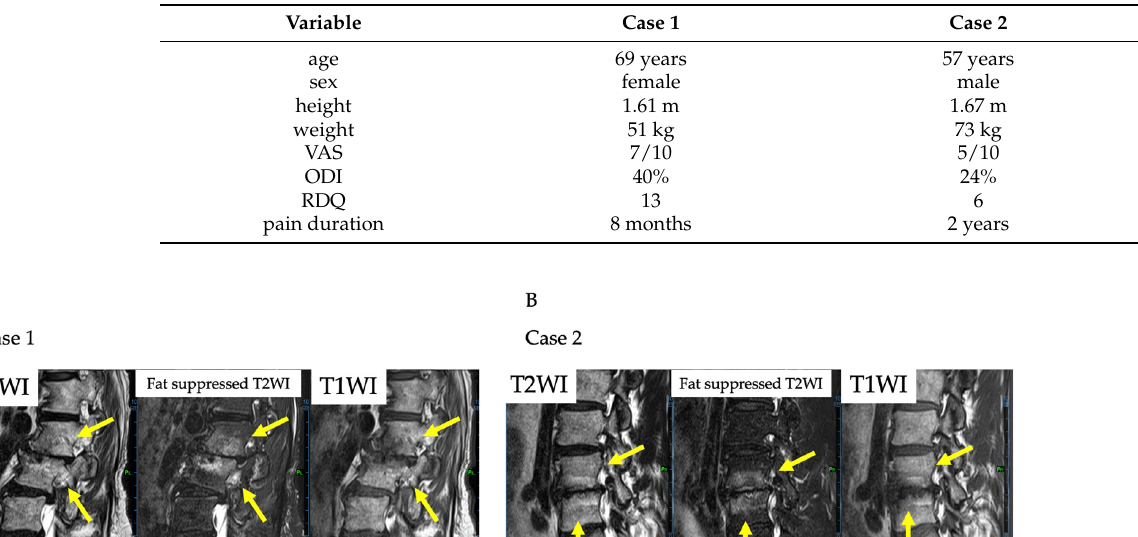
Table 3. Patient demographics.